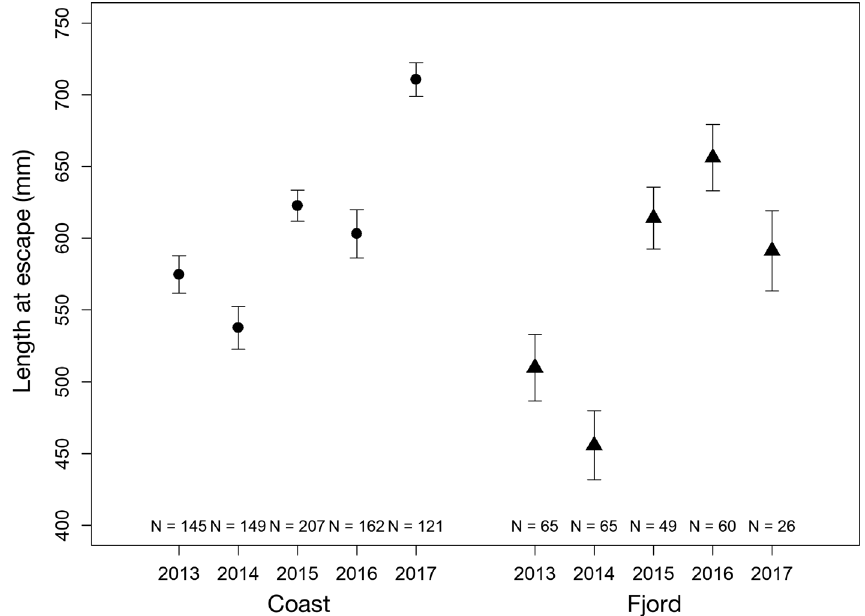
Fig. 3. Mean (±SE) length at escape (mm) on the coast and in the fjord from 2013 to 2017. Sample size is given on the graph for both locations in each When only including salmon that escaped after some 0.2%, respectively. Overall percentages of escapees time in the sea cages (length at escape >300 mm) the with 0, 1, 2 and 3 winter bands in the fjord were 51, overall percentages of escapees with 0, 1, 2, 3 and 4 33, 14 and 2%, respectively. There was no difference winter bands on the coast were 55, 27, 16, 1 and between the coast and the fjord in the proportions of